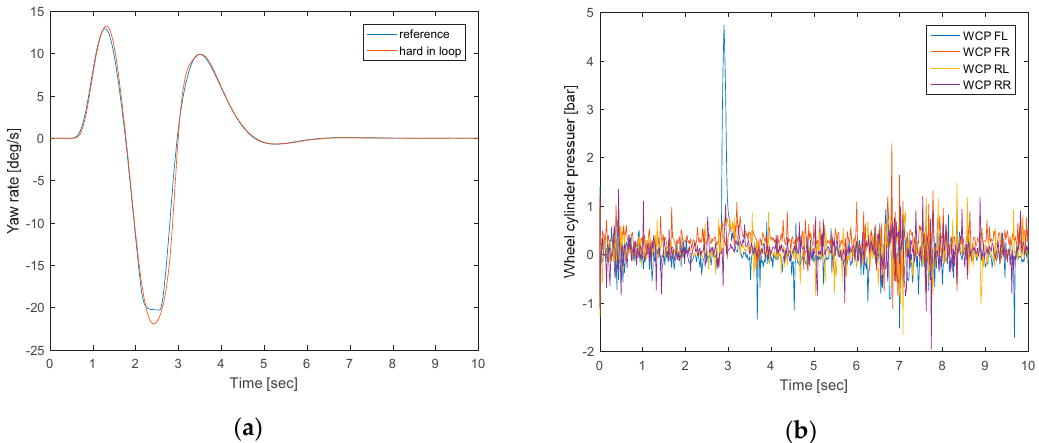
Figure 16. Test results based on the conventional PID-based controller at 𝑢 = 100 km/h and 𝜇 = 0.5. ( a ) is a comparison of the nominal and actual values of the yaw rate, and ( b ) is the wheel cylinder pressure value collected from the wheel cylinder pressure sensor.